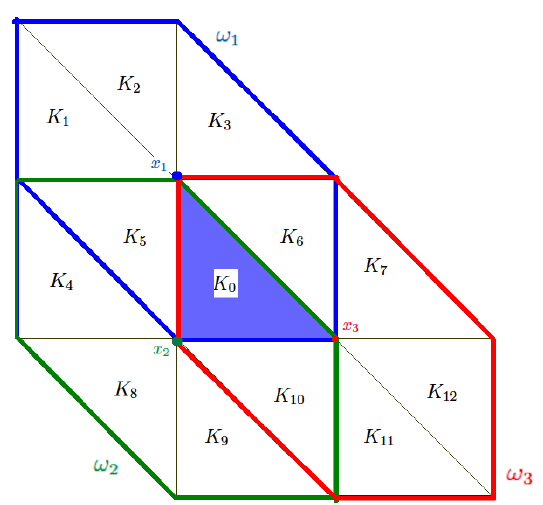
Figure 3. An illustration of a target coarse block K 0 and related